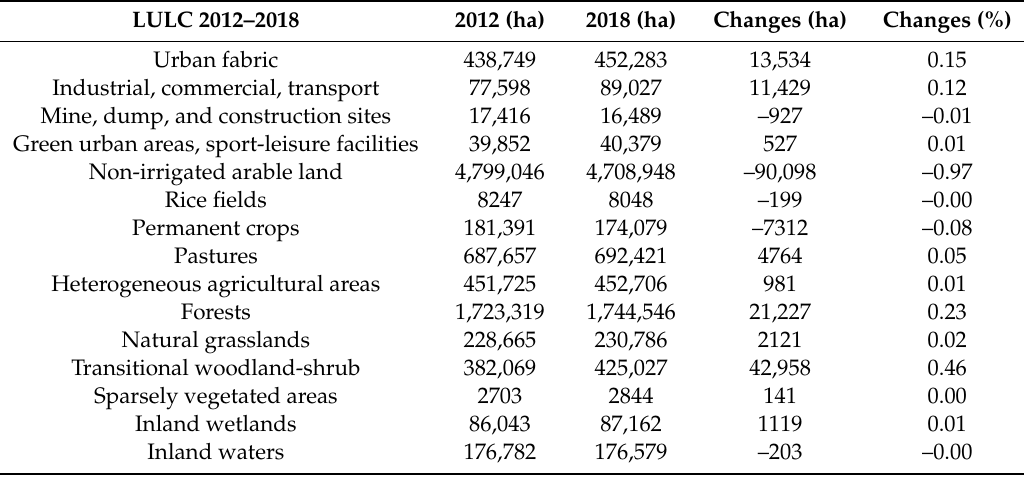
Table A4. Area a ff ected by LULC change in Hungary between 2012 and